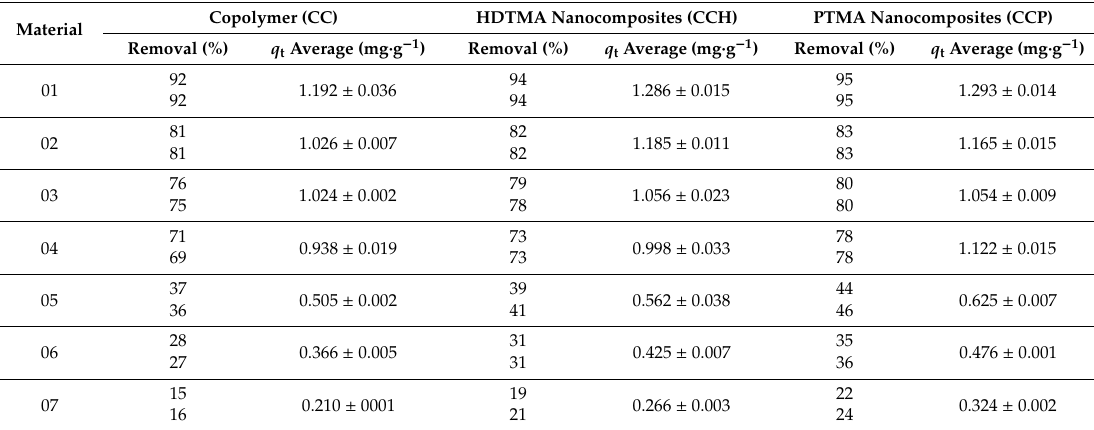
Table 5. Removal percentages and q average value for the di ff erent synthesized